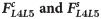
Results for FL4L5candFL4L5s in all four RTs.Axial compression force (FL4L5c, upper row) and anterior shear (FL4L5s, lower row) computed in relation to changes in sacral slope (SS) and pelvic incidence (PI) in the four lumbar typologies (RT1, RT2, RT3, RT4). The results for the three sagittal vertical axis (SVA) conditions interpreting the balanced global alignment (SVAmed) and the backward and frontward imbalanced alignments (SVAback and SVAfront) are presented as green, blue, and red surfaces, respectively.